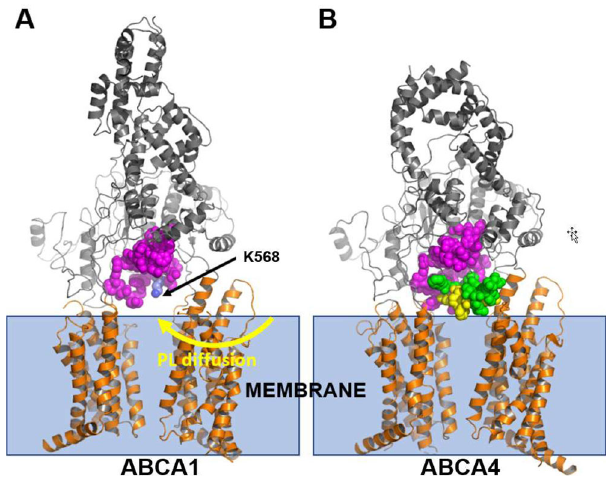
Fig. 7 | Structural features of ABCA1 and ABCA4 may contribute to their transporting substrates in opposite directions. Our model for substrate trans- port by ABCA1 proposes that the negatively charged phosphate group of PL in the outerlea fl etofthemembraneinitiallyinteractswiththepositivelychargedresidue K568. It then moves through the gateway ( A , magenta) and into the elongated hydrophobic tunnel. The ATP-free structure of ABCA4 exhibits a structure analo- gous to the gateway ( B , magenta). An extended loop, termed the S-loop (green, space- fi lling) because itbinds N-retinylidene-phosphatidylethanolamine ( B , yellow space- fi lling), resides adjacent to the gatewayof ABCA4.The locationofthe S-loop in the outward-facing transmembrane cavity of ABCA4 may prevent movement of N-retinylidene-phosphatidylethanolamine into the gateway of